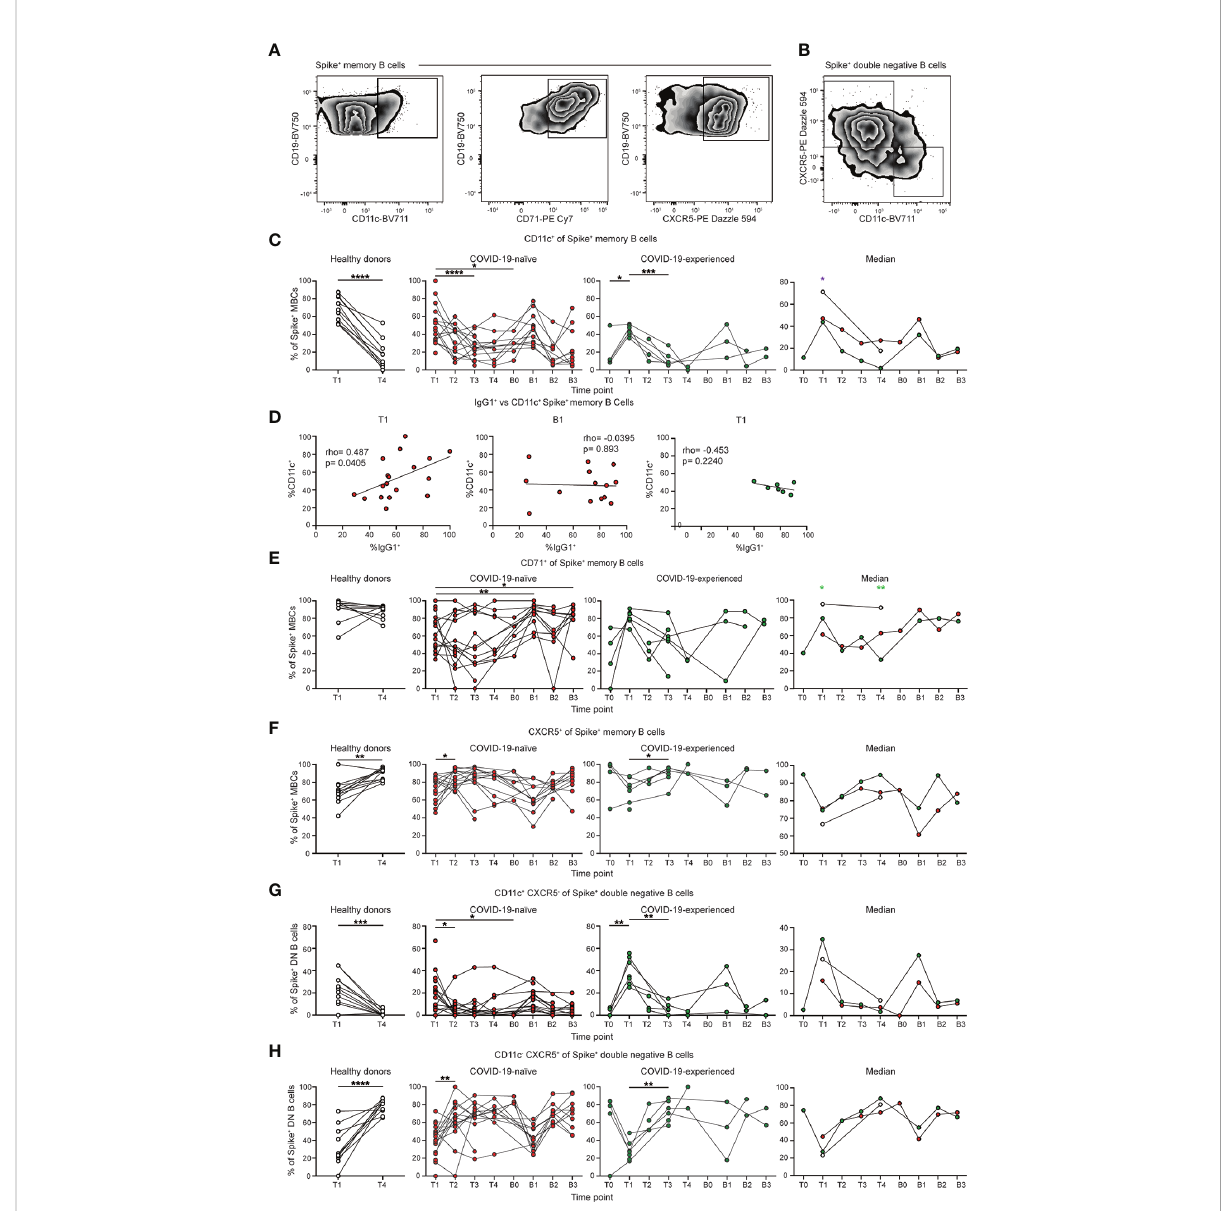
FIGURE 4 Spike-speci fi c memory B cells from PAD patients display reduced CD11c expression. (A) Representative fl ow cytometry plots of the expression of CD11c, CD71, and CXCR5 on Spike + memory (IgD lo CD20 + CD38 int-lo CD27 + ) B cells. (B) Representative fl ow cytometry plots of the expression of CD11c and CXCR5 on Spike + double negative (IgD lo CD20 + CD38 int-lo CD27 - ) B cells. (C) Percentage of Spike + memory B cells that are CD11c + in the healthy donor (left, white), COVID-19-naïve PAD (middle left, red), and COVID-19-experienced PAD (middle right, green) cohorts. Median percentage of CD11c + cells in all groups is shown on right. (D) Correlation between percentage of Spike + memory B cells that are IgG1 + and CD11c + at T1 (left) and B1 (middle) in the COVID-19-naïve PAD patients, and at T1 (right) in the. COVID-19-experienced PAD patients. Associations for D are calculated using Pearson rank correlation and shown with Pearson trend lines for visualization. Percentage of Spike + memory B cells that are (E) CD71 + or (F) CXCR5 + in healthy donors (left, white), COVID-19-naïve PAD (middle left, red), and COVID-19- experienced PAD (middle right, green) cohorts. Median percentage of B cells that comprise each population in all groups is shown on right. Percentage of Spike + double negative B cells that are (G) CD11c + CXCR5 - or (H) CD11c - CXCR5 + in the healthy donor (left, white), COVID-19- naïve PAD (middle left, red), and COVID-19-experienced PAD (middle right, green) cohorts. Median percentage of double negative B cells that comprise each population in all groups is shown on right. Statistical analyses in (C, E – H) were performed using a mixed effects model (for trends found between time points) or two-way ANOVA (for trends found between groups shown on the median graphs) with Fisher ’ s least signi fi cant difference testing. Signi fi cance testing between time points was limited to comparisons relative to T1. Above the median graphs, a green asterisk indicates a comparison between the COVID-19-naïve and healthy donor groups, an orange asterisk indicates a comparison between the COVID-19-naïve and COVID-19-experienced groups, and a purple asterisk indicates a comparison between the COVID-19- experienced and healthy donor groups (* p < 0.05; ** p < 0.01; *** p < 0.001; **** p < 0.0001). See also Figure